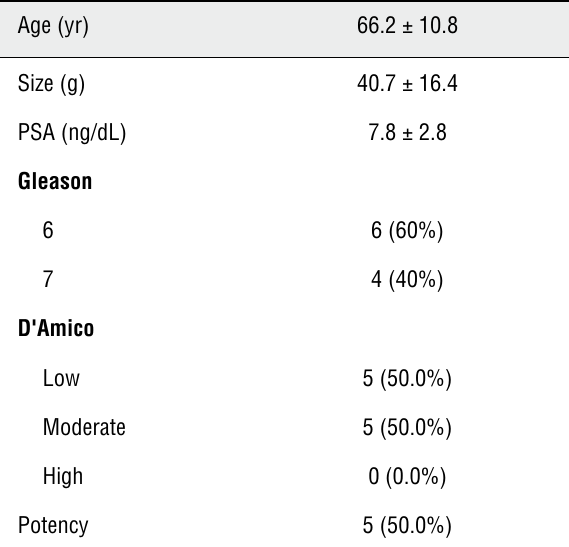
Table 1 - Patient demographic and Pre-operative data.